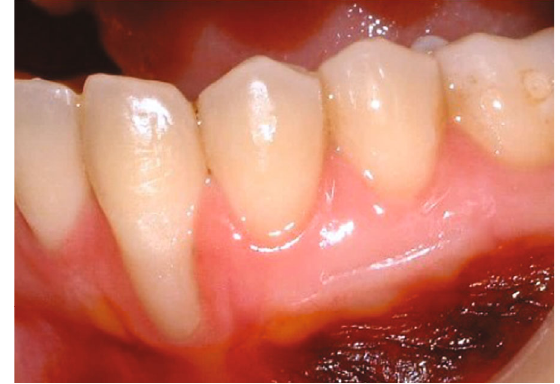
Figure 6: Eight weeks later, the donor area was increased to approximately 6mm.